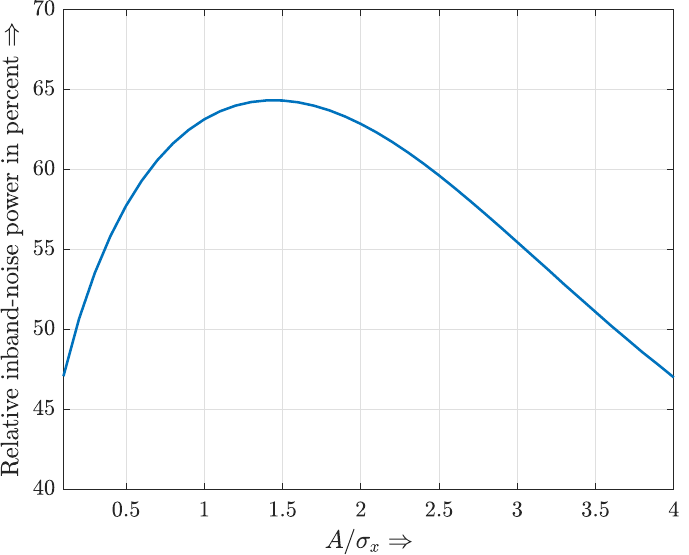
Figure 9. Power of the uncorrelated clipping noise that is located inside the transmission band, relative to the entire power of the uncorrelated clipping